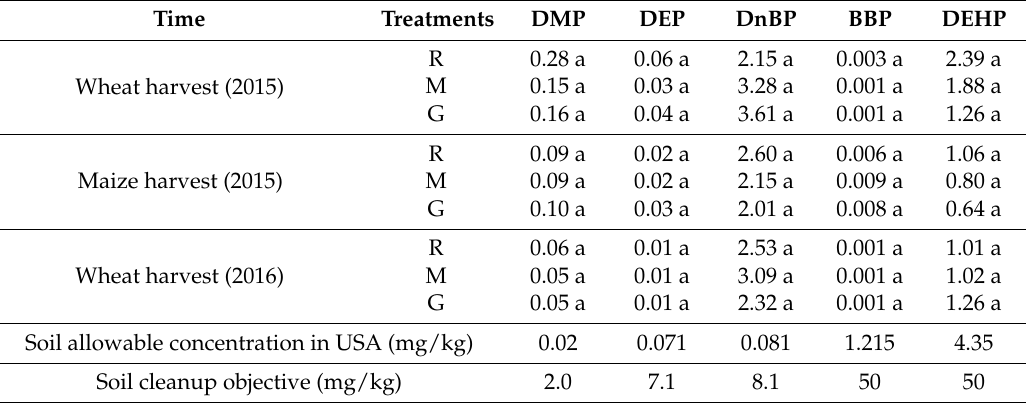
Table 5. Concentrations of each individual PAE in the soil at crop harvest in 2015 and 2016 Unit: mg/kg. Time